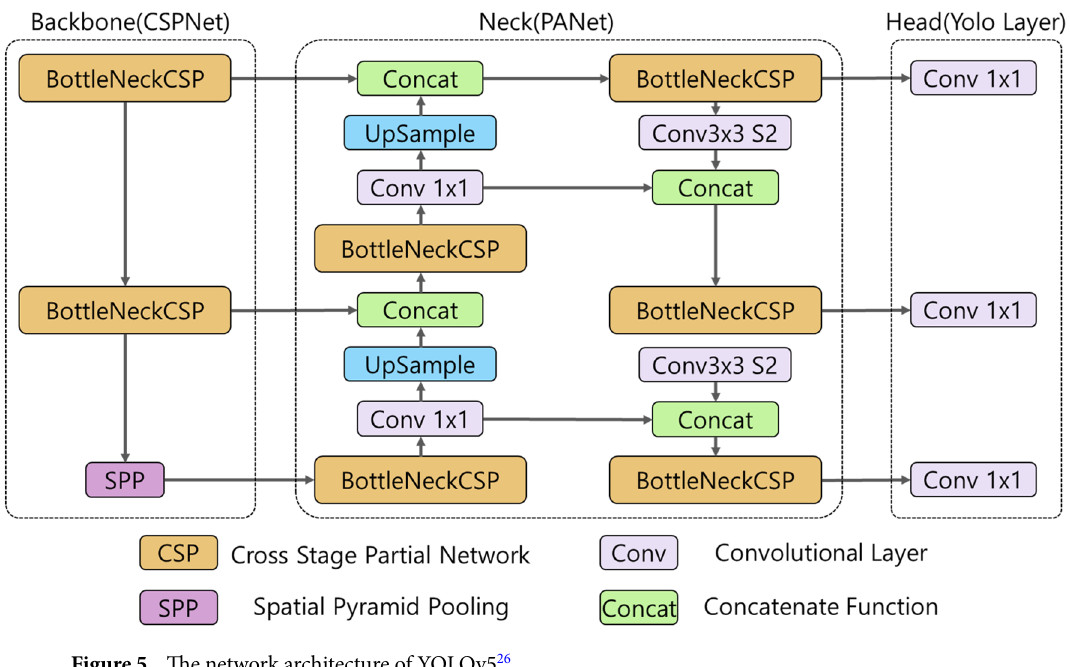
Figure 5. The network architecture of YOLOv5 26